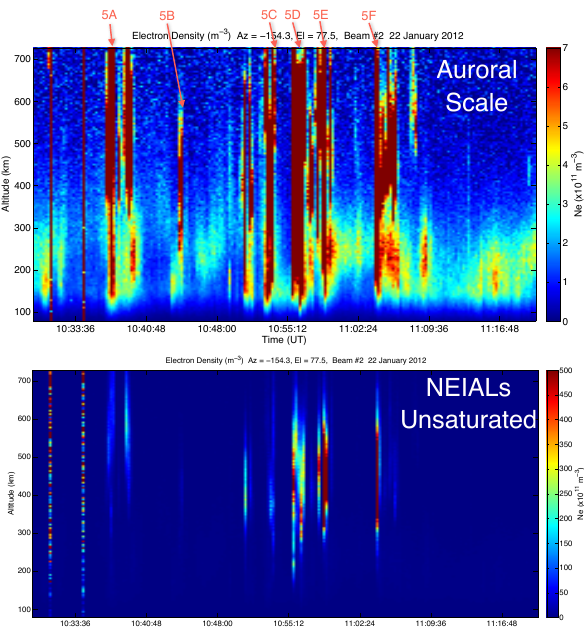
Figure 16. Event 5: top: PFISR electron density profiles, covering a time period of about 45min with tall auroral rays in the magnetic zenith. The strong NEIAL returns can be seen to extend up to high altitudes ( > 600km) in some cases. The times marked 5A–5F are the times of the NEIAL spectra shown in Fig. 17. Bottom: same time period with intensity scale set so the NEIALs are not oversaturated.